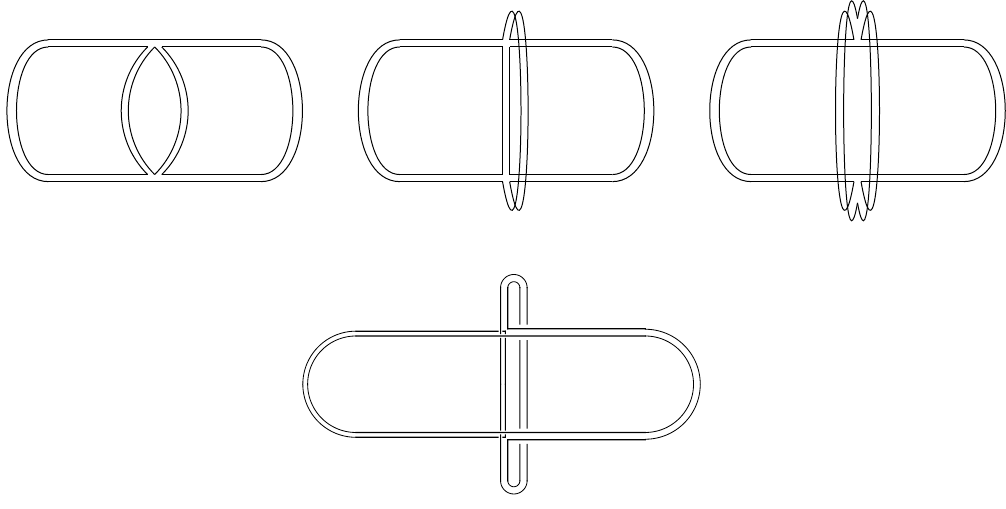
Figure 4. Top: the three diagrams on top arise from the standard vertex shown in figure 3. Each of these diagrams has a counterpart, but with the standard vertex switched with the mixed up vertex. Bottom: a representative diagram from the mixed up vertex diagrams is shown. This is the 1-hump mixed up vertex diagram. There are four leading order in N diagrams like this one, and the same goes for the standard and 4-hump